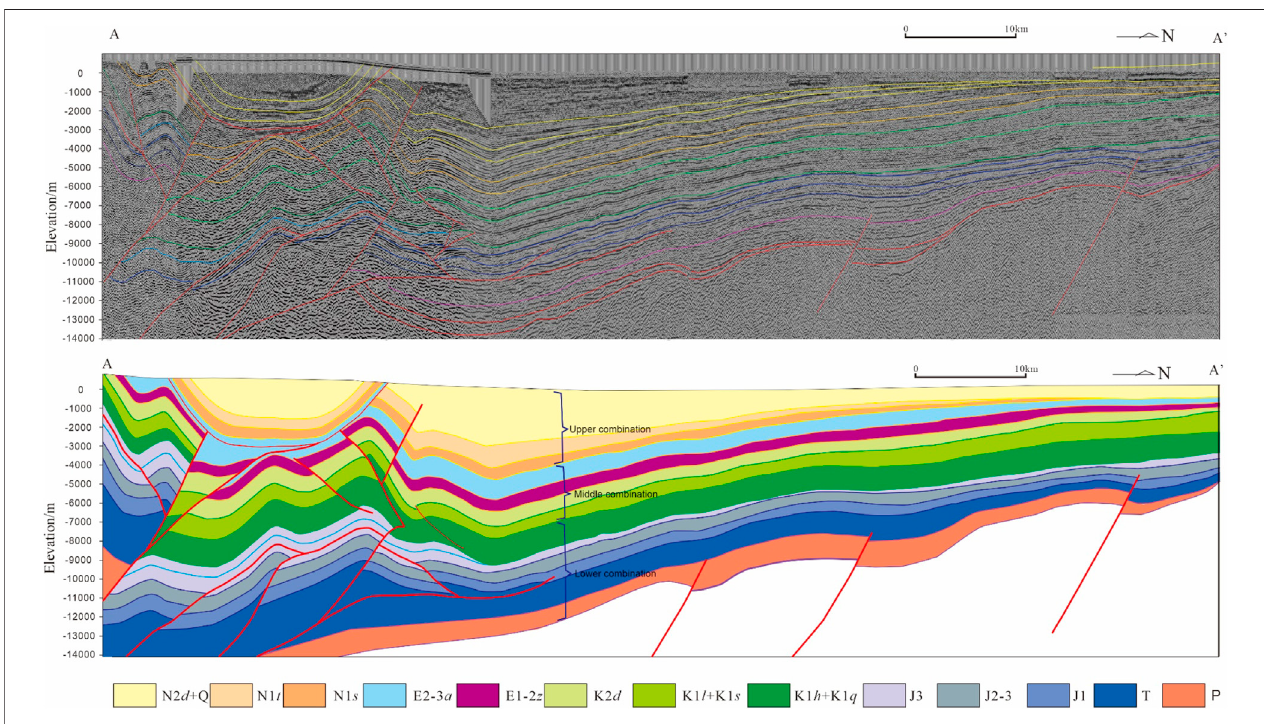
FIGURE 3 | N – S cross-section in the middle segment of the SJFB shows the seismic and structural and stratigraphy characteristics. The location of this section is shown in Figure 1 . The three sets of combinations can be divided vertically by the regional detachment layer and caprock.